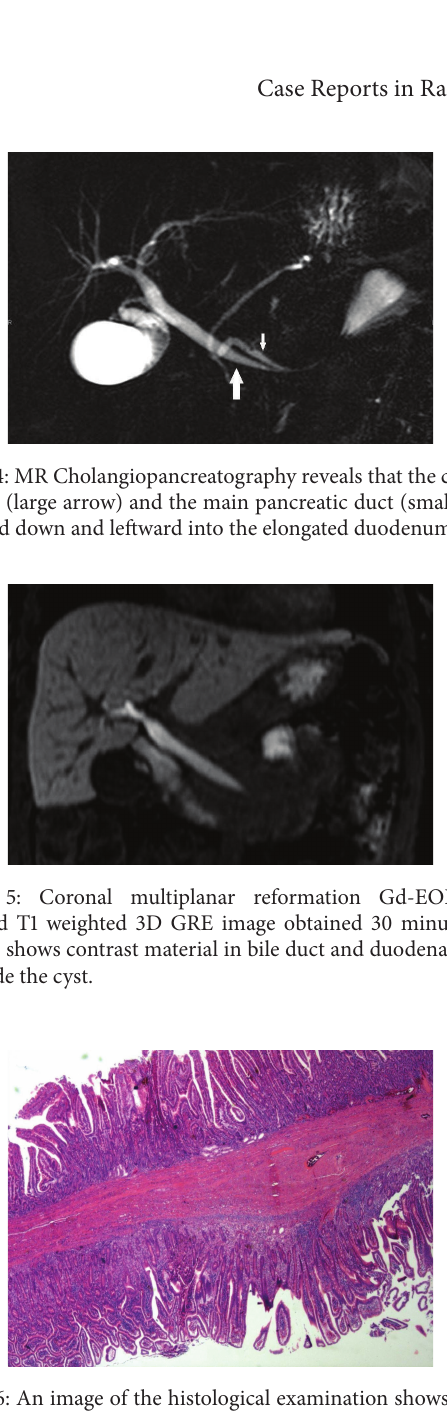
Figure 6: An image of the histological examination shows charac- teristic findings of a duplication cyst and a double muscle layer, with their mucosal and submucosal